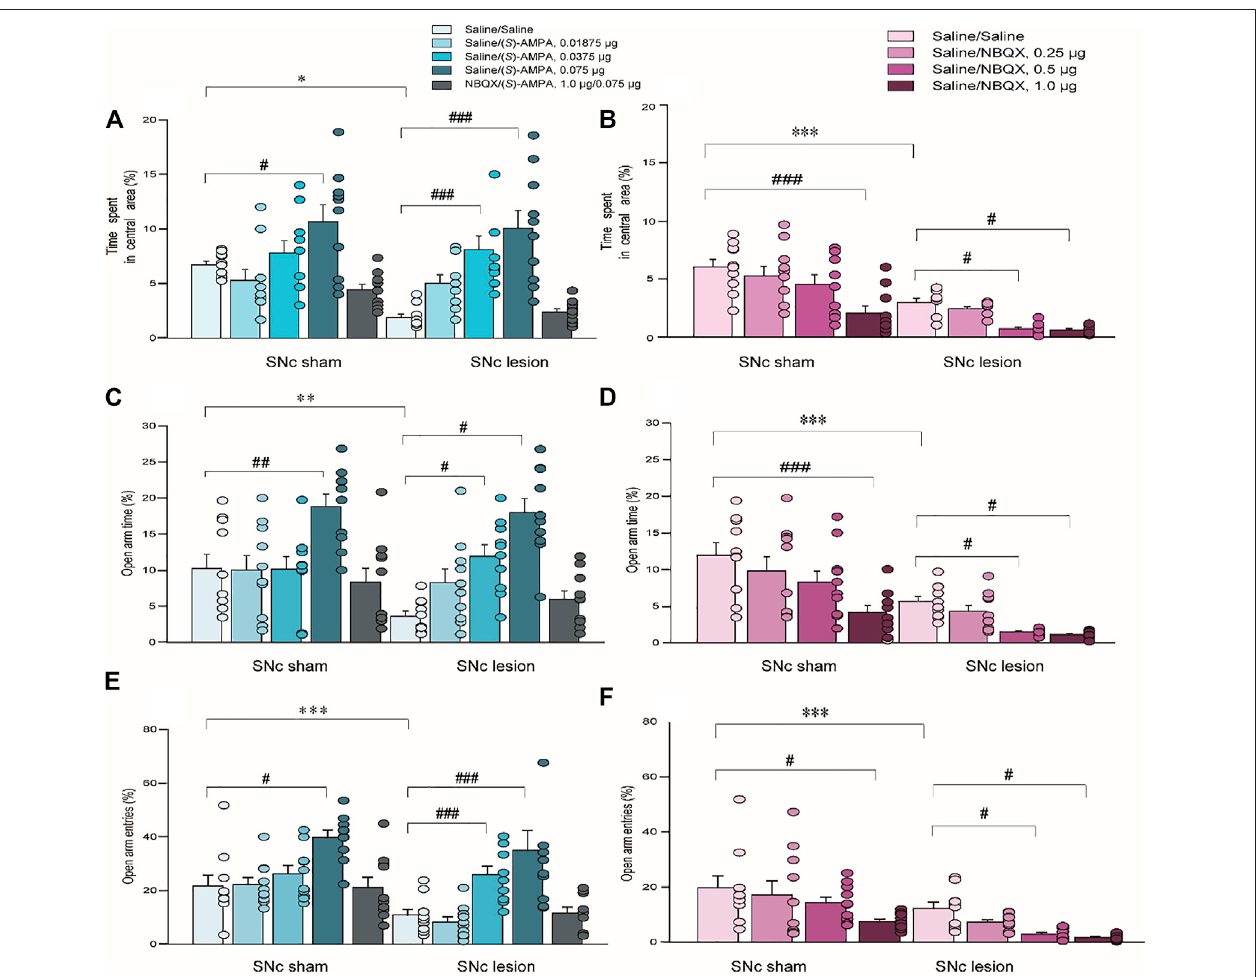
FIGURE 4 | The effects of 6-OHDA lesions and the intra-LHb microinjections of (S)-AMPA and NBQX as the AMPAR agonist and antagonist, respectively, on anxiety-like behaviors measured using the OFT and EPM. Unilateral SNc lesions reduced the percent time spent in the central area in the OFT (A,B) , the percent time entering the open arms of the EPM (C,D) , and open-arm entries in the EPM (E,F) , compared to that in sham-operated rats. In both groups, an intra-LHb injection of ( S )- AMPAincreasedthepercentageoftimespentincentralarea (A) ,andthepercentopen-armtime (C) andopenarmentries (E) relativetothesaline/salineinjectionin lesioned rats; whereas the injection caused anxiolytic-like behaviors in both groups (A,C,E) . Pretreatment with NBQX (1.0 μ g/0.3 μ l) administered into the LHb blocked theeffectsof( S )-AMPA(0.075 μ g/0.3 μ l)onanxiety-likebehaviors.Intra-LHbadministrationofvehicle/NBQXsigni fi cantlyloweredthepercentageoftimespentincentral area (B) , open-arm time (D) and entries into open arms (F) relative to vehicle/vehicle injection in the two groups. The doses leading to the alterations in anxiety-like behaviors in the lesioned rats were lower than those in sham-operated rats. # p < 0.05, ## p < 0.01, ### p < 0.001 vs . vehicle/vehicle injection into the LHb in the same group; * p < 0.05, ** p < 0.01, *** p < 0.001 vs . sham-operated rats; a two-way ANOVA followed by Bonferroni ’ s test. Data are represented as means ± SEM; n = 10 rats/